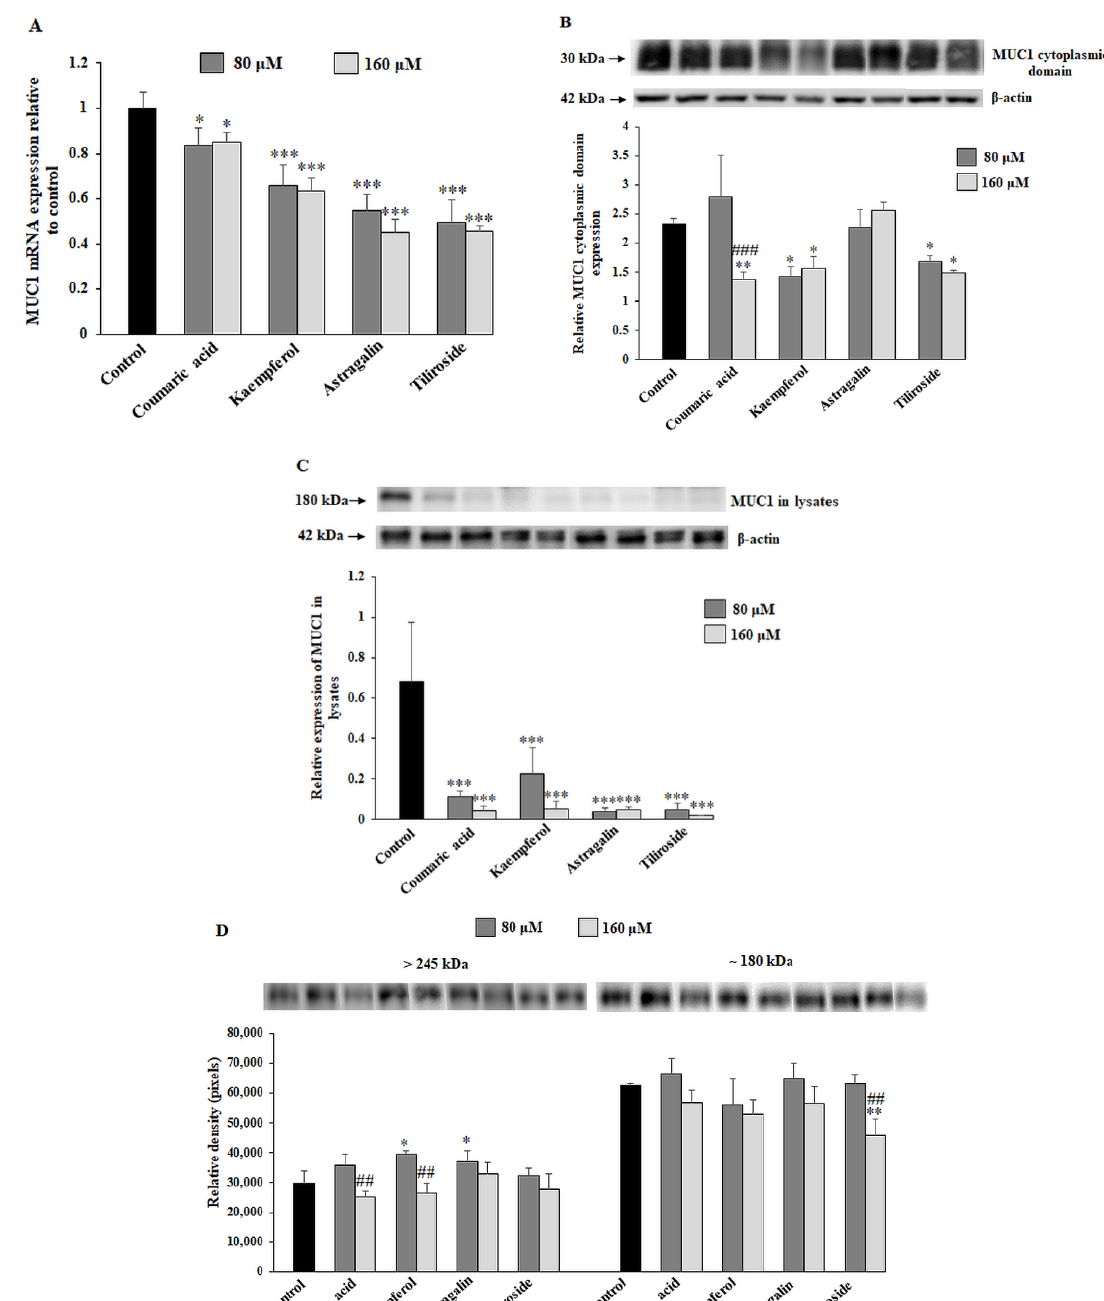
Figure 3. The effect of coumaric acid, kaempferol, astragalin and tiliroside on MUC1 mRNA, MUC1 cytoplasmic domain, MUC1 expression in cell lysates and culture medium. The AGS cancer cells were incubated for 24 h with 80 and 160 µ M concentrations of the polyphenolics. mRNA was determined by RT-PCR ( A ). The results are shown as a relative fold change in mRNA expression of gene in comparison to the gene in control, where expression was set at 1. ± SD are the mean of triplicate cultures. * p < 0.05, *** p < 0.001. MUC1 cytoplasmic domain ( B ), MUC1 in cell lysates ( C ) and in culture medium ( D ) were assessed by Western blot analysis. β -actin served as a protein loading control. The intensities of the bands were quantified by densitometric analysis. Data represent the mean ± SD of triplicate culture. * p < 0.05, ** p < 0.01, *** p < 0.001 compared to untreated control; ## p < 0.01, ### p < 0.001 compared to lower concentration (80 µ M) of specific polyphenolic